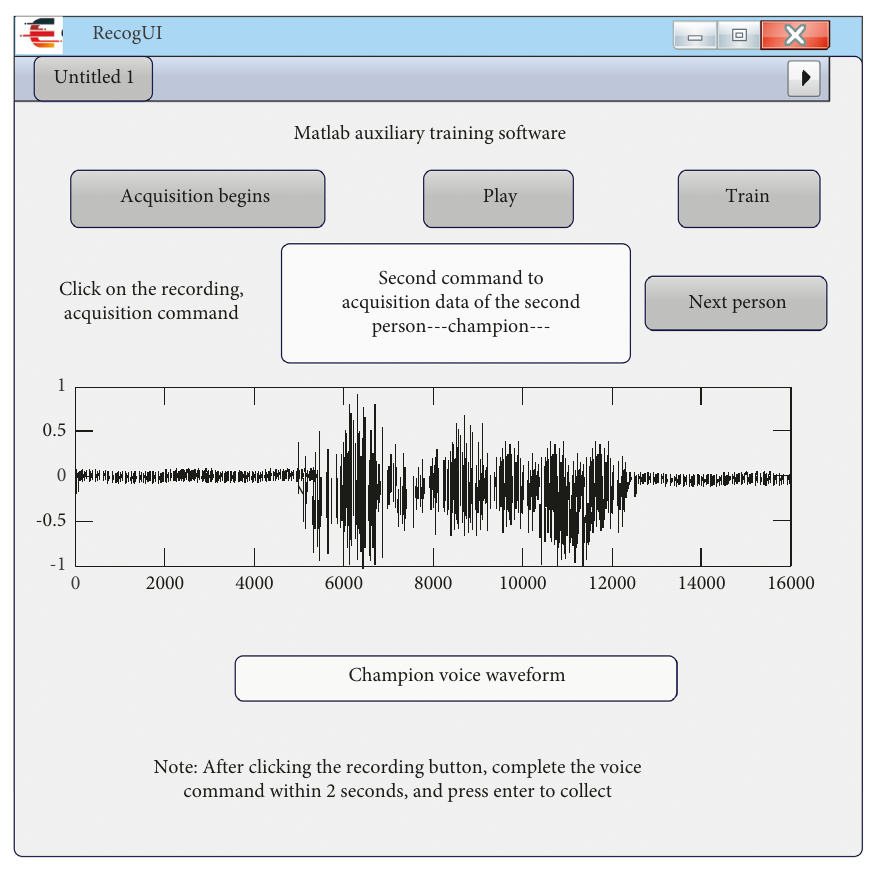
Figure 9: MATLAB GUI